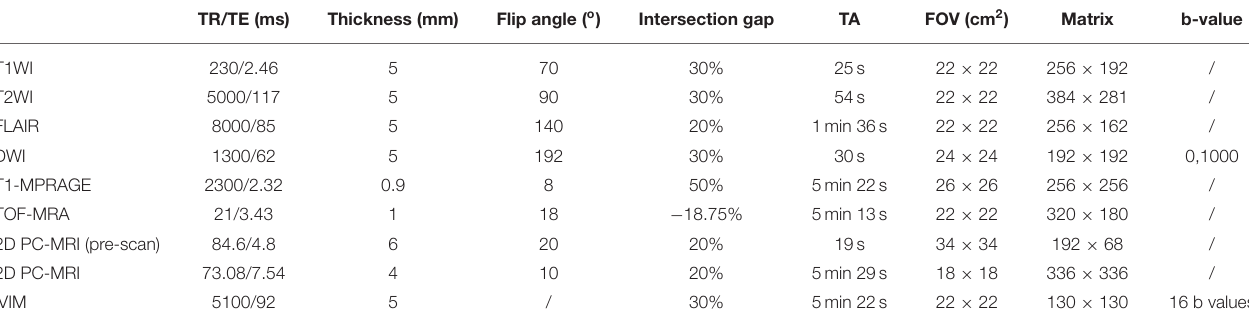
TABLE 2 | MRI scanning sequences and parameters.